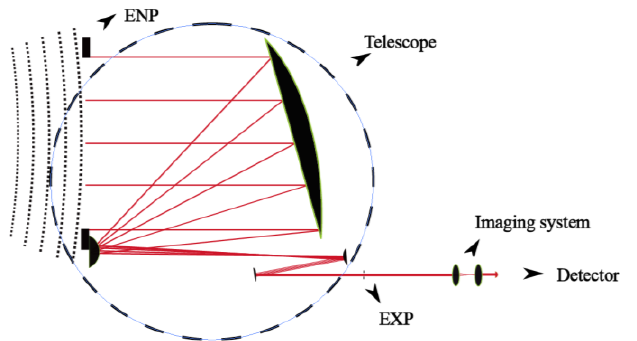
Figure 1. A schematic diagram of the far-field beam received by the gravitational wave telescope. The far-field beam is received by the entrance pupil of the telescope, reflected by the telescope, and then passed through the imaging system to reach the detector.